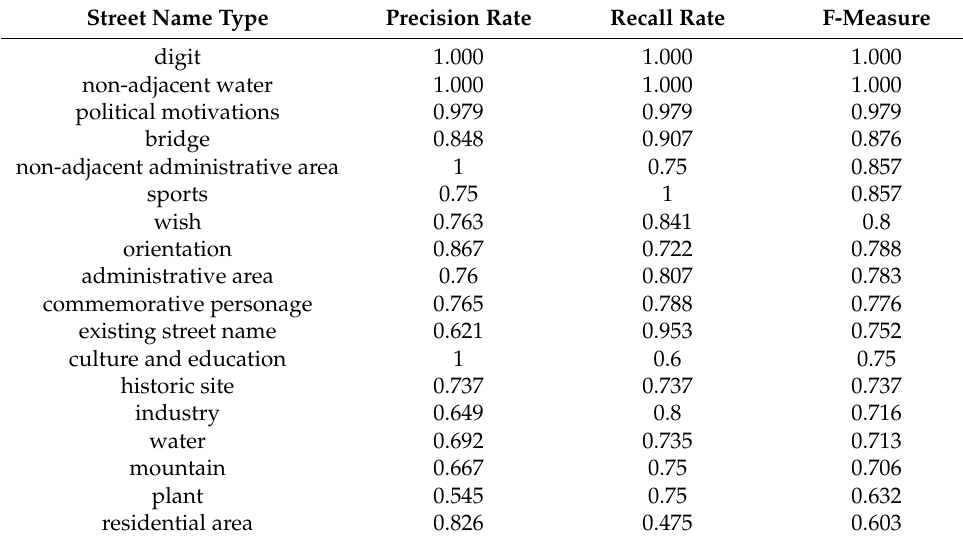
Table 3. Classification accuracy of common street name